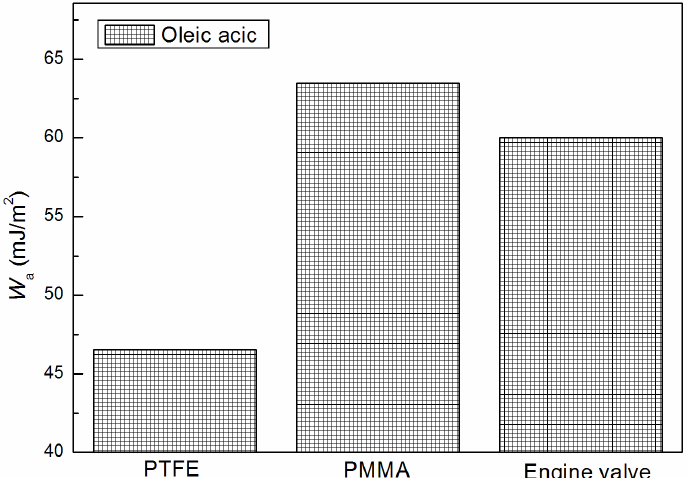
Figure 7. The values of the adhesion work ( W a ) for oleic acid to the PTFE, PMMA, and engine valve surface.